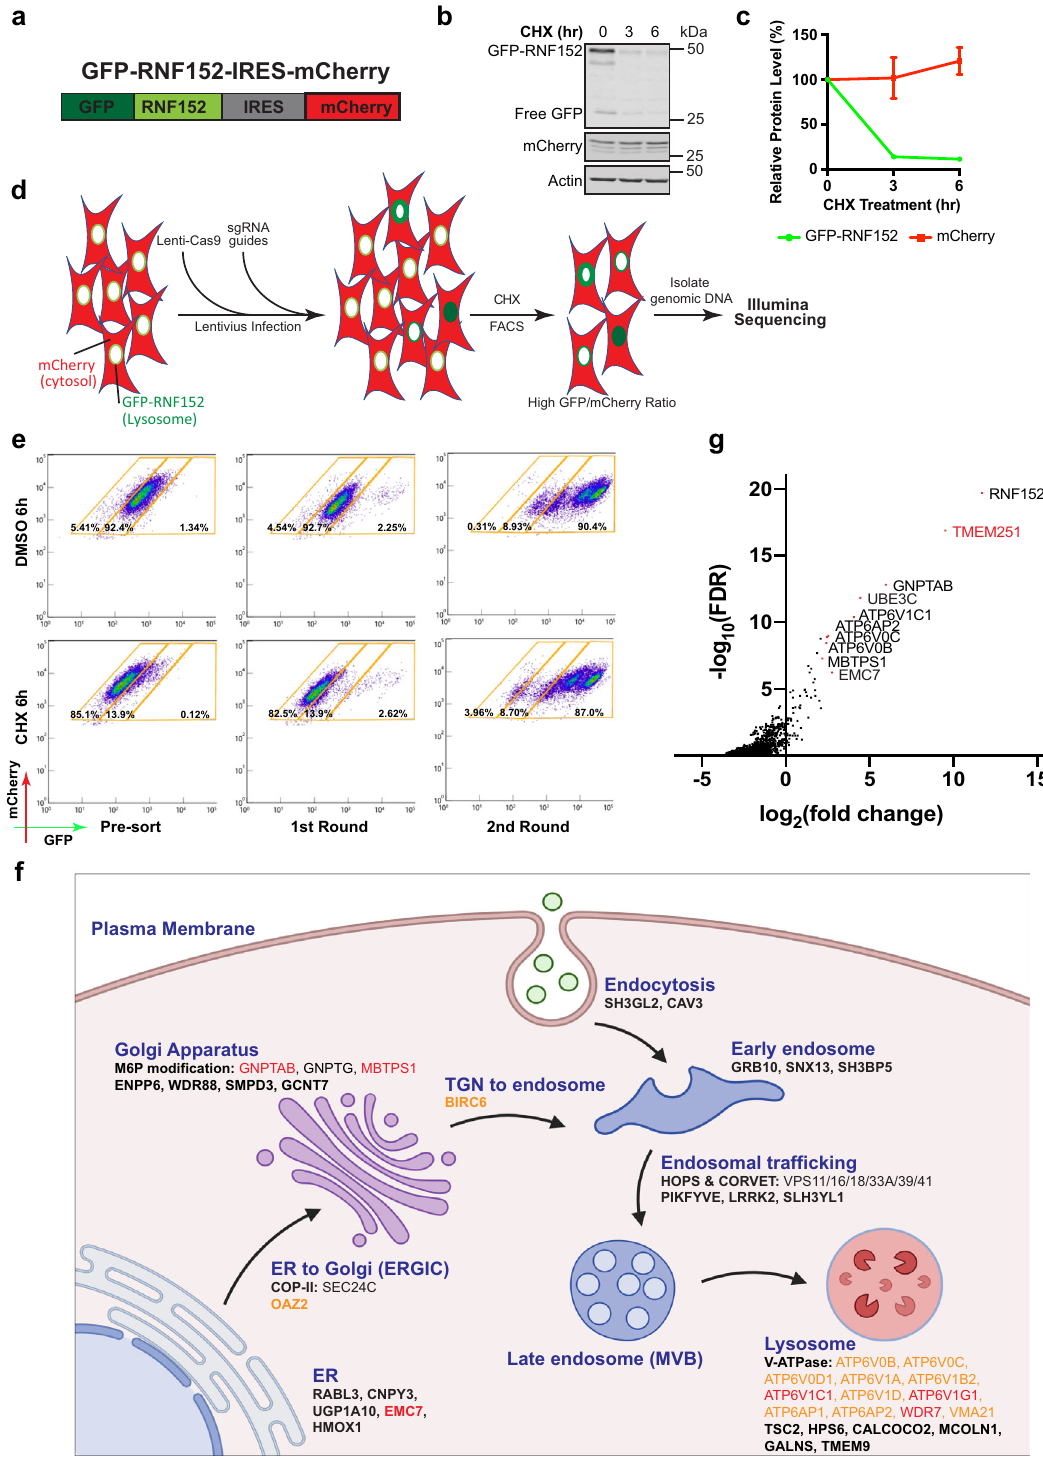
Fig.1|Agenome-wideCRISPR-Cas9knockoutscreentoidentifygenesessential for lysosome function. a A schematic representation of the reporter construct. b CHX chase assay of stably expressed GFP-RNF152 and mCherry in HEK293 cells. c Quanti fi cation of the protein levels in b . Mean of 3 independent replicates is shown. Error bars represent standard deviation. d A schematic representation of the CRISPR-Cas9 screen to identify genes essential for lysosome function. e Flow